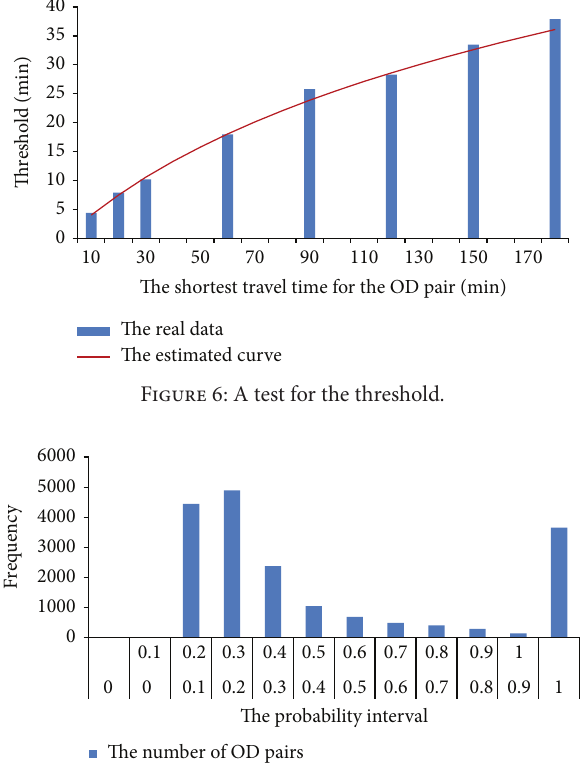
Figure 6: A test for the threshold.